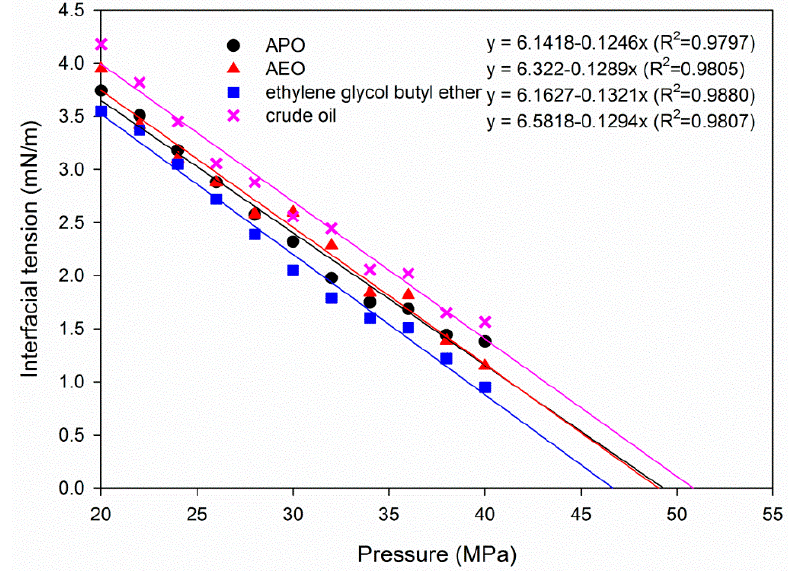
Figure 9. Changes of CO 2 –oil IFTs with pressures for the crude oil diluted with different oil-soluble surfactants.